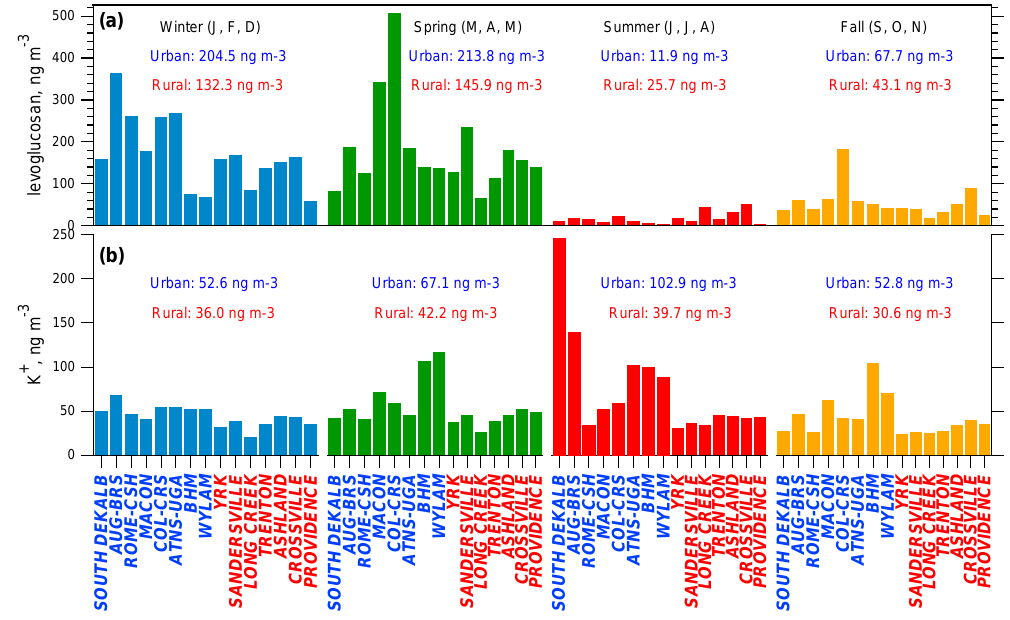
Fig. 4. Seasonal (Winter, Spring, Summer, Fall) variations of levoglucosan (a) and K + (b) concentrations at each site. Site names in blue and red are urban and rural sites, respectively. The mean concentrations of levoglucosan and K + by urban/rural segregation for each season are given in the plots.